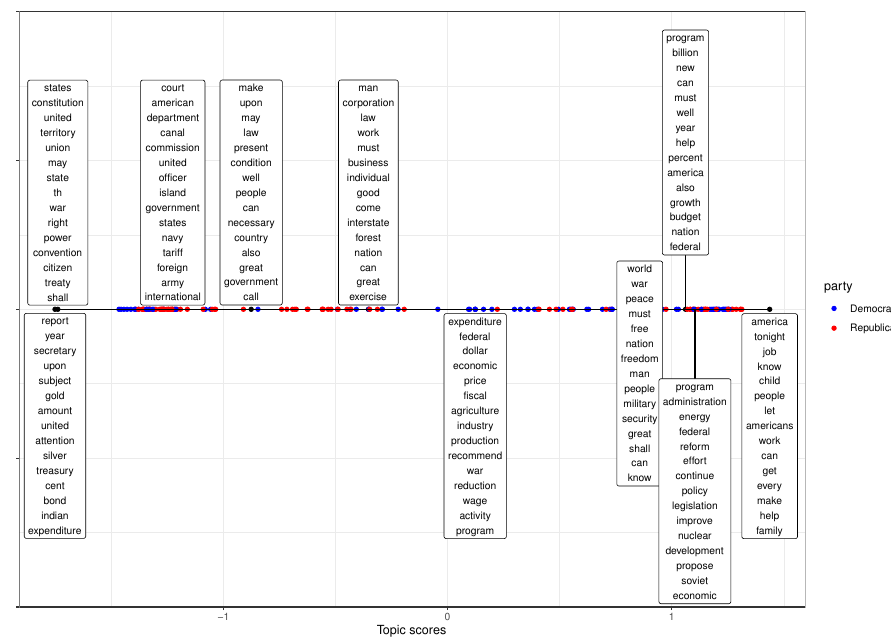
Figure 6. Topic scores learned via Topic Scaling (10